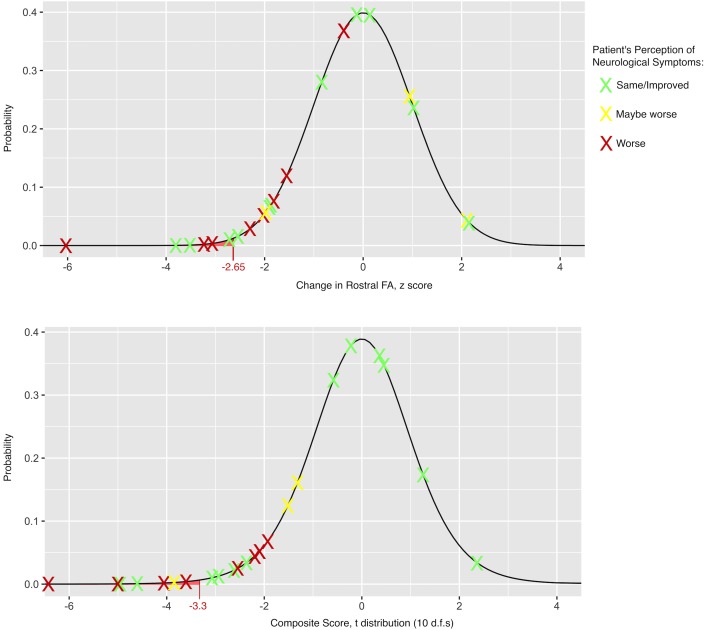
Distribution of observed changes in Quantitative MRI (qMRI) metrics at follow-up.The observed changes in age-corrected qMRI metrics for individual subjects (displayed as Xs) are plotted in relation to the expected distribution based on the null hypothesis of no change, using test-retest reliability data to characterize the SEM and calculate z scores. The results for FARostral (top panel) are overlaid on a normal distribution. The composite score is calculated as an average of z scores for each metric, which is overlaid on a t distribution with 10 d.f.s (bottom panel). Each result is colour-coded based on the patient’s subjective impression of neurological worsening (red: worse, yellow: maybe worse, and green: the same or better). CSA: cross-sectional area; d.f.s: degrees of freedom; FA: fractional anisotropy; MCL: maximally compressed level; PDF: probability density function, SEM: standard error of measurement.